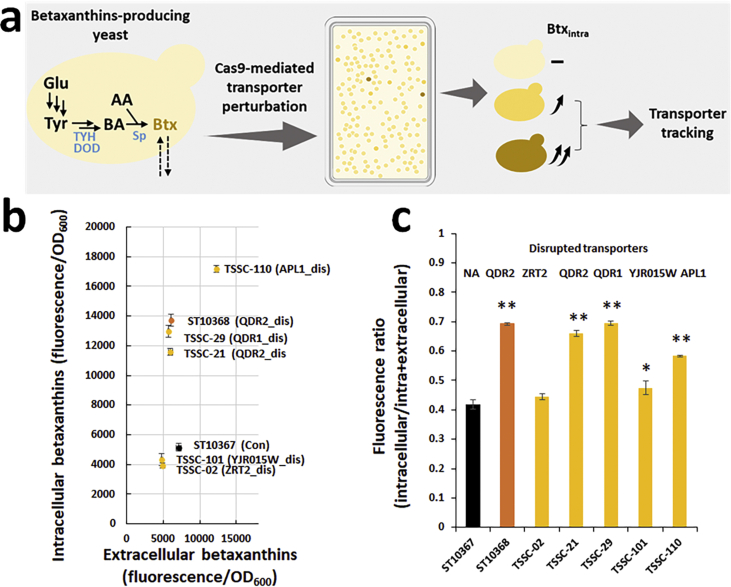
Transporter identification for betaxanthins (a) Tyrosine hydroxylase (TYH) and DOPA dioxygenase (DOD) were expressed in yeast to produce betalamic acid (BA). BA spontaneously reacts with intracellular amino acids, generating yellow to orange fluorescent pigments - betaxanthins. The betaxanthins producing yeast is transformed with plasmid library for transporter disruption, and the resulting clones are tested for increased intracellular betaxanthins accumulation (Btxintra). The causal transporter disruption are identified by sgRNA-donor sequencing. Betaxanthins production (b) and distribution (c) by variant strains pre-selected in the screening, based on increased color intensity in colonies and higher cellular betaxanthins retention. Data shown in panel b and c are mean values ± SDs of biological triplicates. Statistical difference between control (ST10367) and indicated strains was determined by two-tailed Student's t-test. *P < 0.05; **P < 0.01.